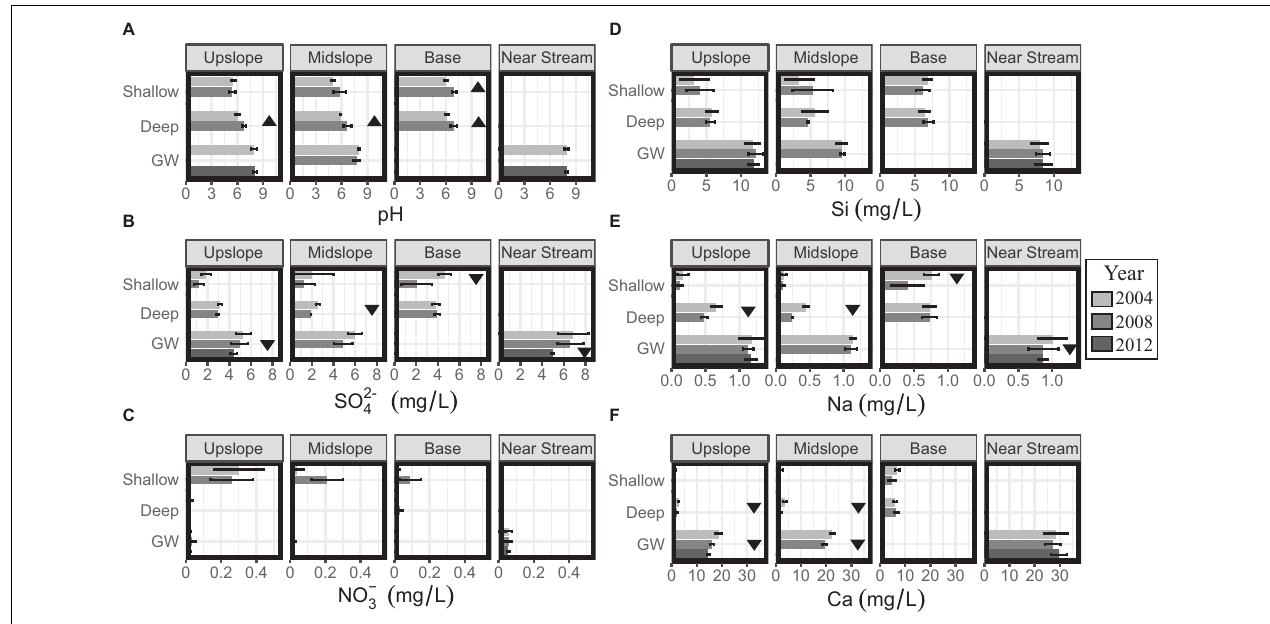
FIGURE 3 | Mean annual (A) pH and (B–F) concentrations of selected solutes in soil water (shallow = 15 cm and deep = 50 cm) and GW at four landscape positions (upslope, slope, base, and near stream) between 2004 and 2012. Base of the hill (soil solution samples) and near stream (GW well) are in proximity to each other. Triangles indicate the directionality of statistically significant trends on the complete time series of data for each depth and landscape position. TABLE 2 | Average stream water pH and concentration of selected solutes (mg/L) during baseflow and stormflow conditions from 1991 to 2015.